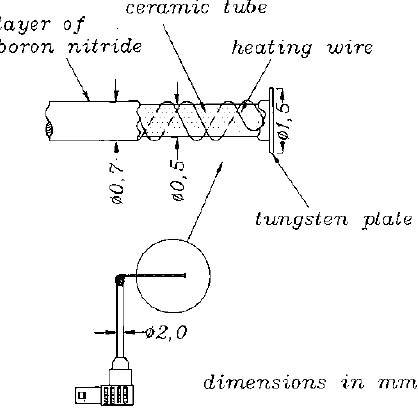
Figure 3. Heatable plane tungsten probe for measurements in a magnetized potassium plasma; drawing taken from [21,22].